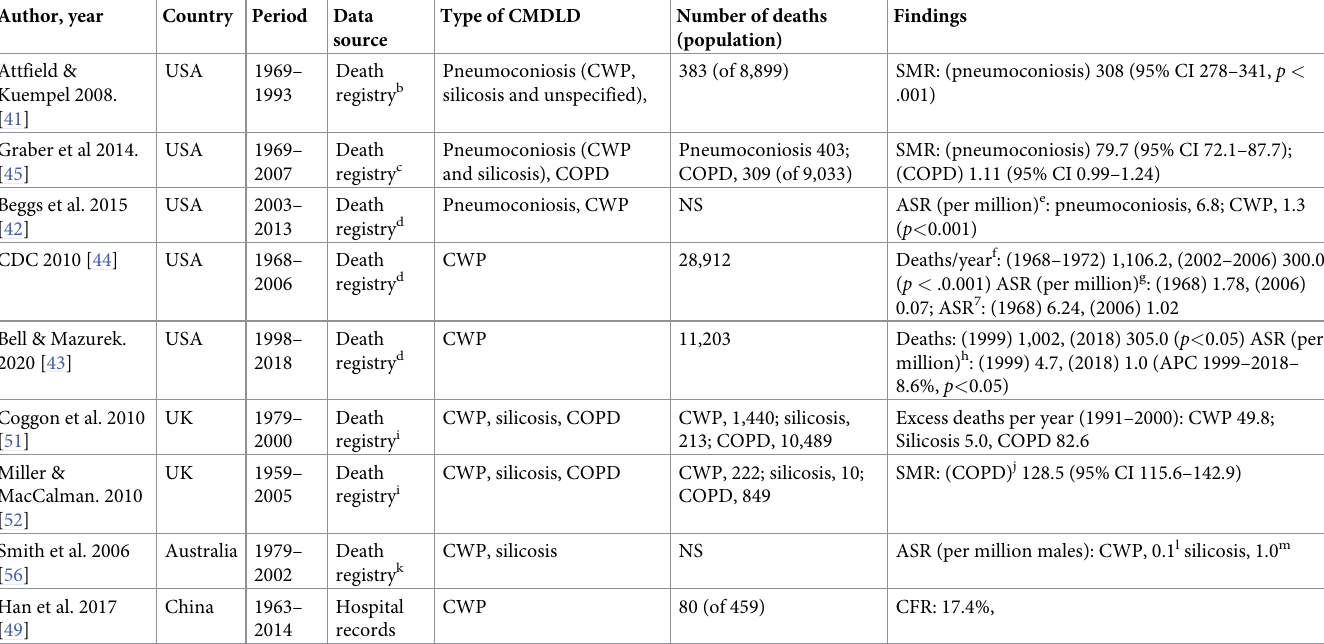
Table 7. Summary of included studies for mortality or survival due to coal mine dust lung